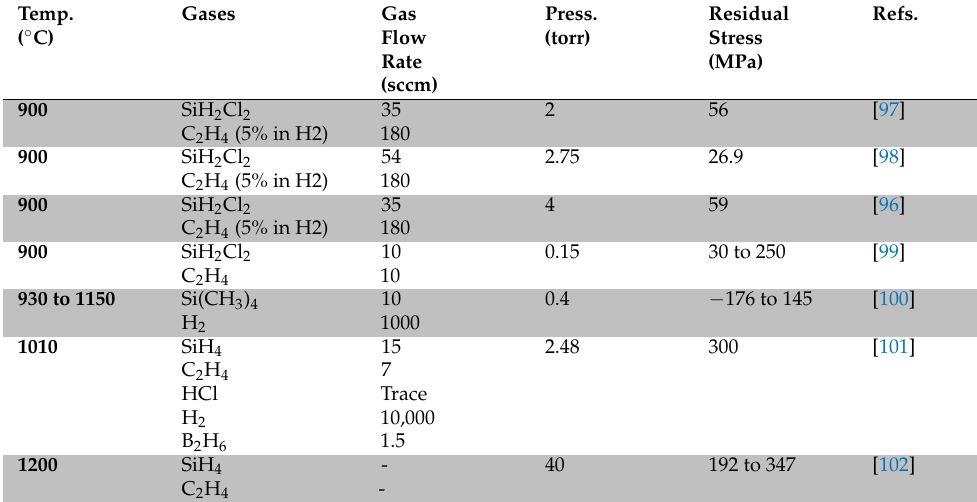
Table 6. Reported Residual Stresses for LPCVD Polycrystalline SiC thin-film layers for Various Processing Conditions.